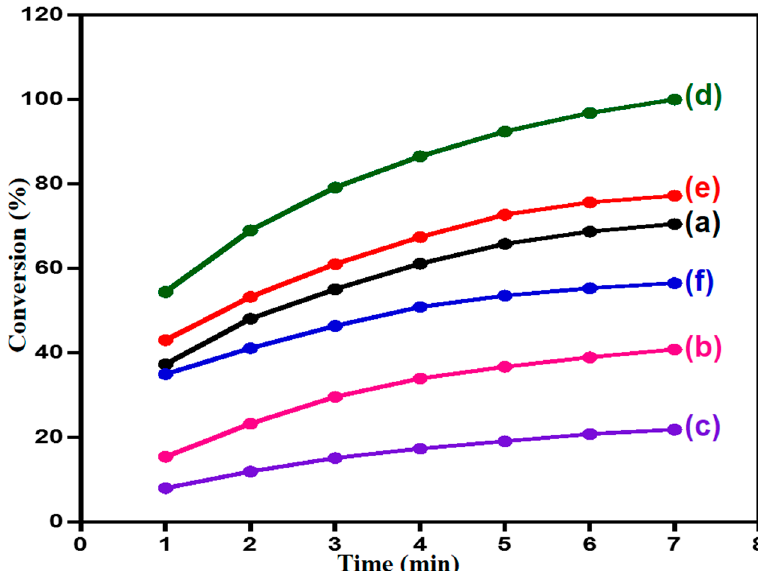
Figure 7. Graphical representation of benzyl alcohol oxidation catalyzed by ( a ) ZnO x (1%)–MnCO 3 ;